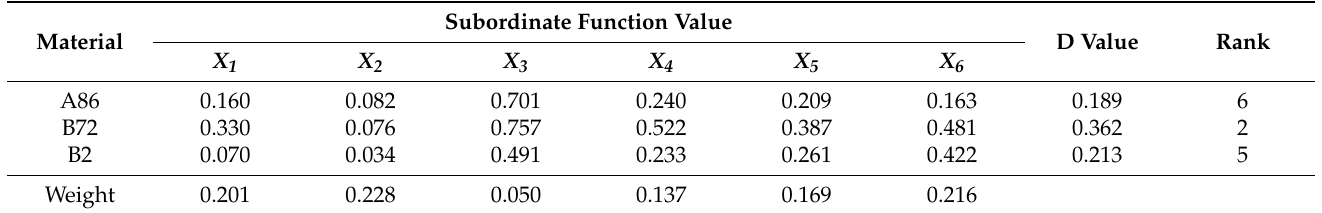
the line. The D values were ranked from large to small as A55 > B72 > B44 > WT > B2 > A86 > B82, indicating that the drought tolerance of A55, B72, and B44 was better than WT (Ta- ble 4), which was consistent with the phenotype (Figure 6).